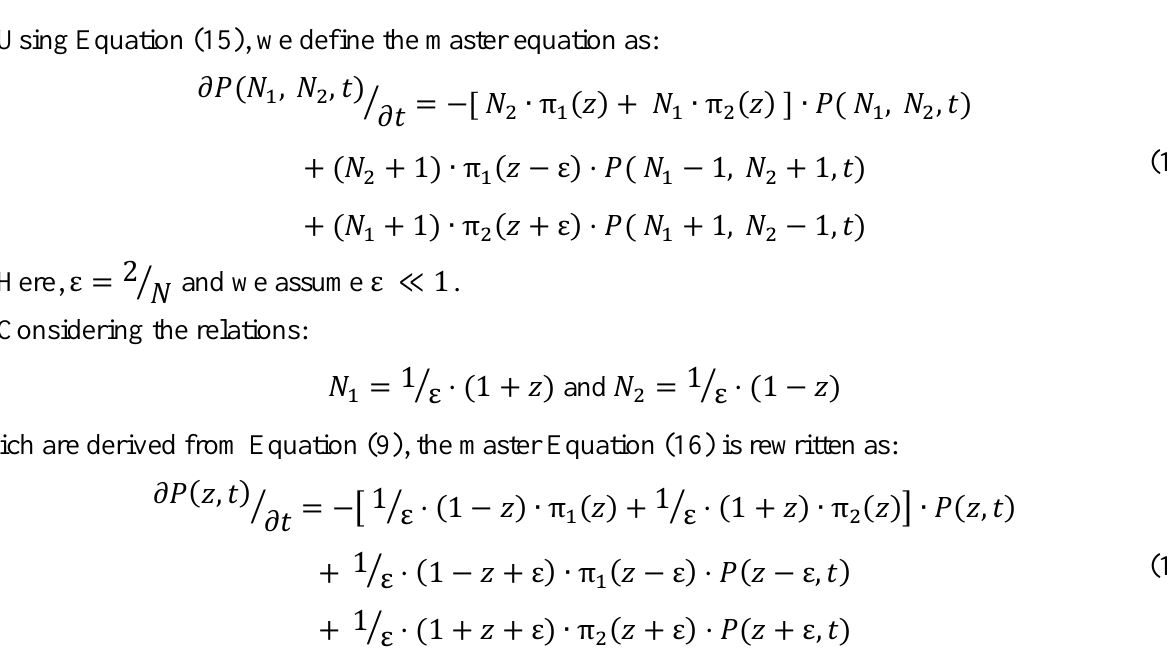
Figure 3. Transitions between state (𝑁